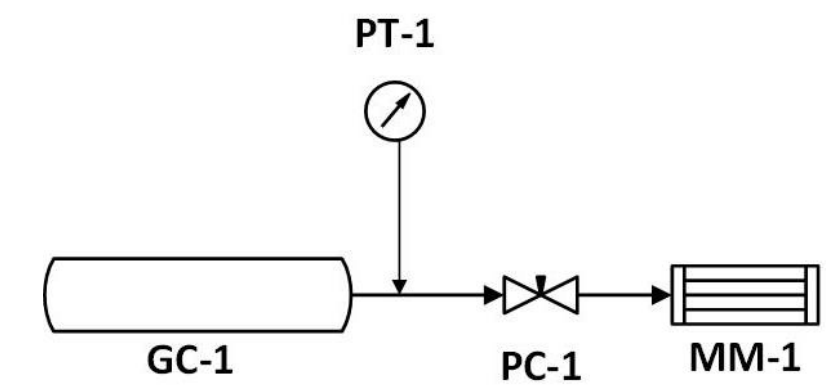
Figure 2. The layout of the experimental gas permeation apparatus.